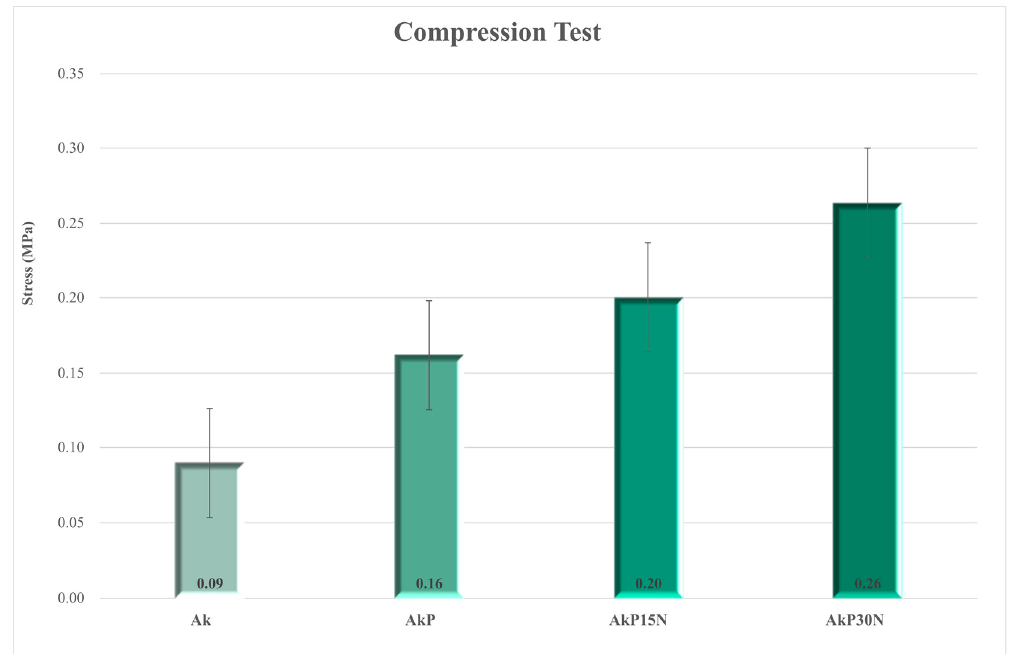
Figure 16. Mean compressive strength of synthesized scaffolds.